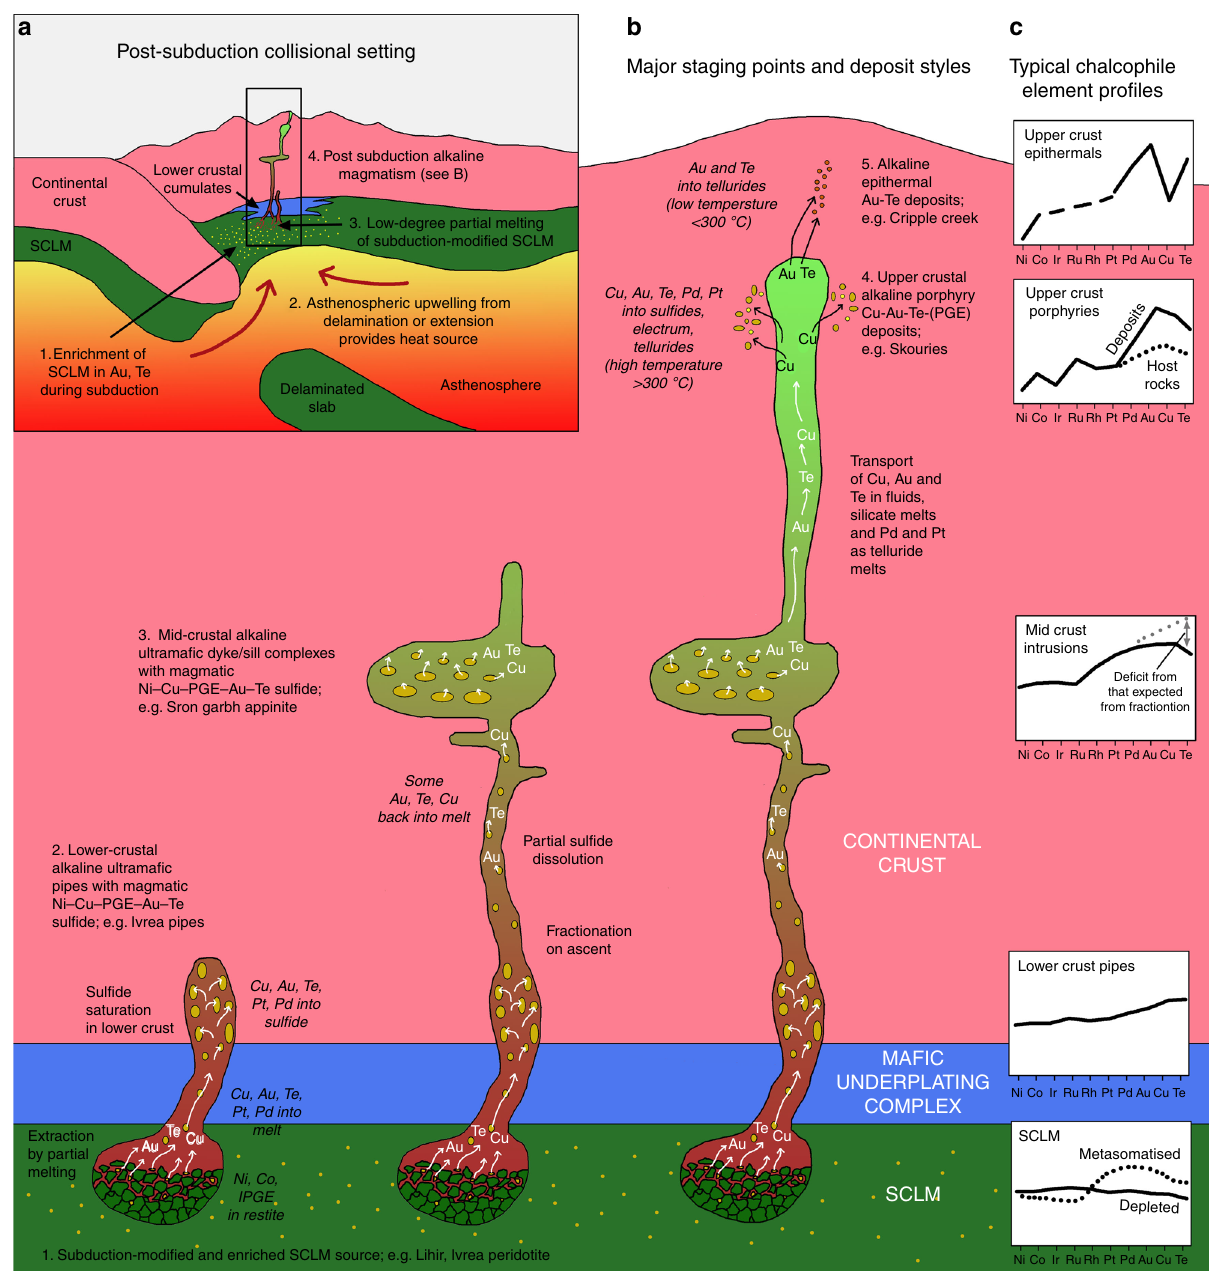
Fig. 3 Metallogenic evolution of post-subduction magmatism. a Schematic representation of post-subduction magmatic setting; b idealised representation of hydrous alkaline magmatic systems that stage in the lower, mid or upper crust, as well as associated representative mineral deposits; c representative chalcophile element pro fi le for each of the scenarios shown in